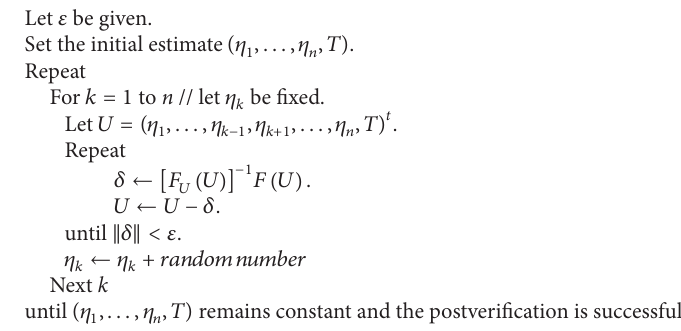
with 𝑥 𝑖 (𝑡 + 𝑇) = 𝑥 𝑖 (𝑡) for each 𝑖 . The coefficients are set as 𝑏 = 𝜅 =